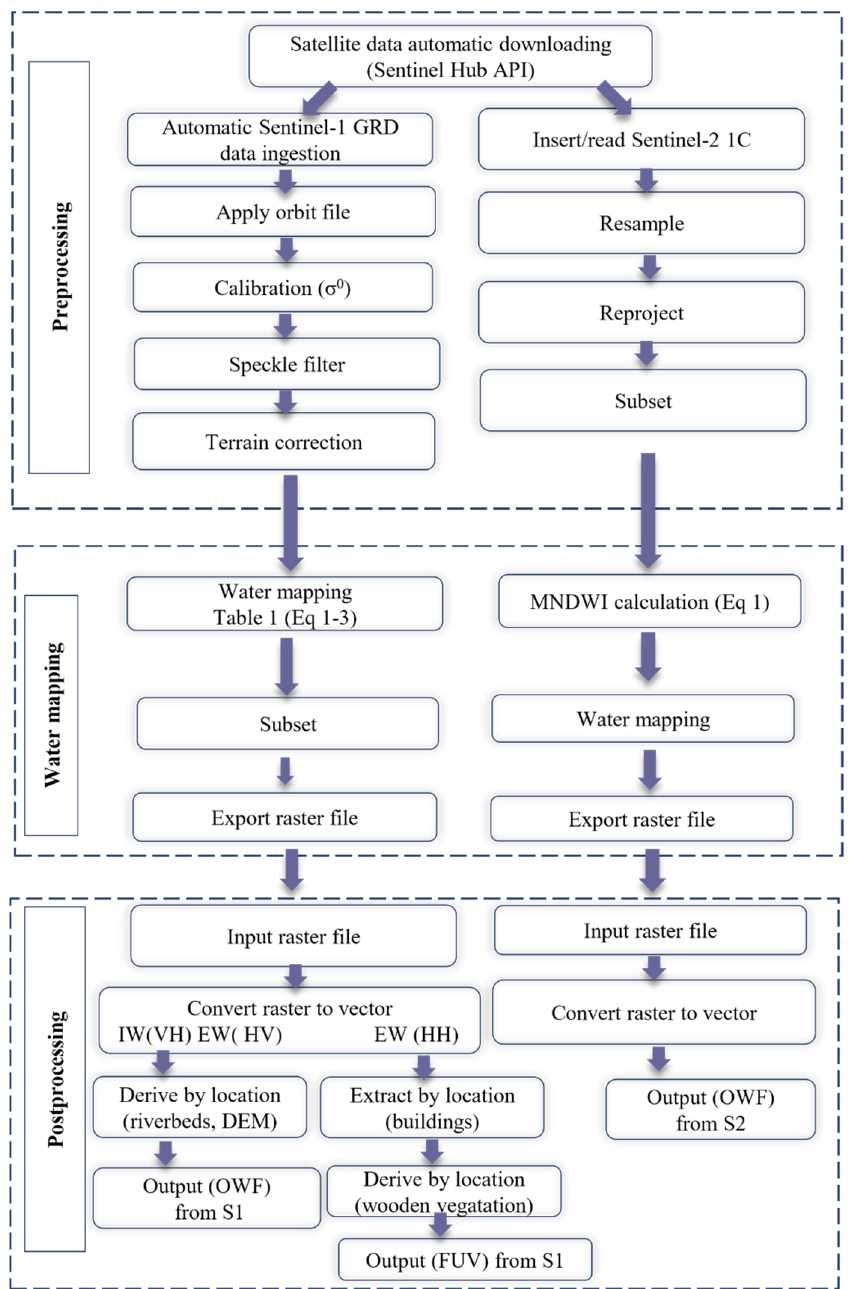
Figure 3. Data processing